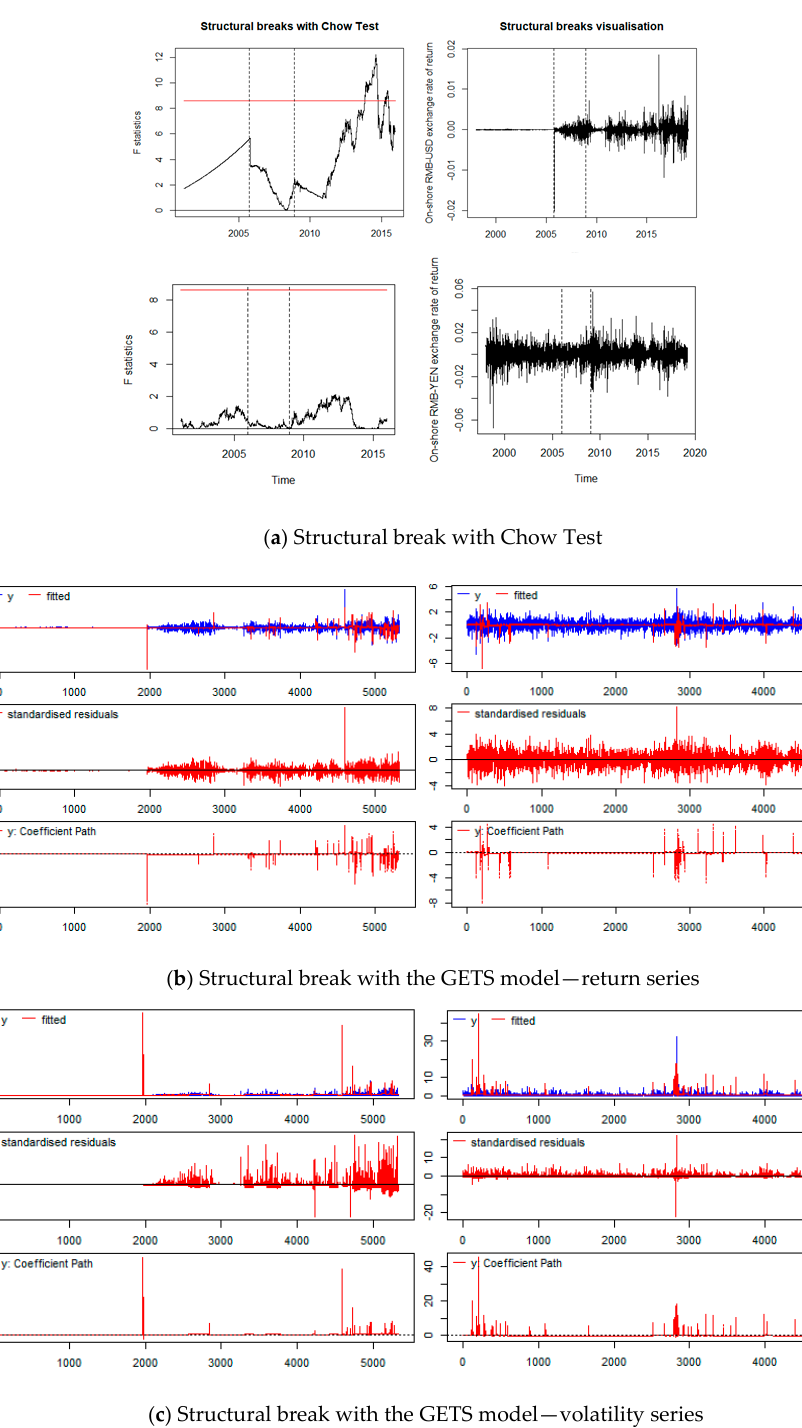
Figure 2. Break Points Visualisation Between 1998 and 2018.